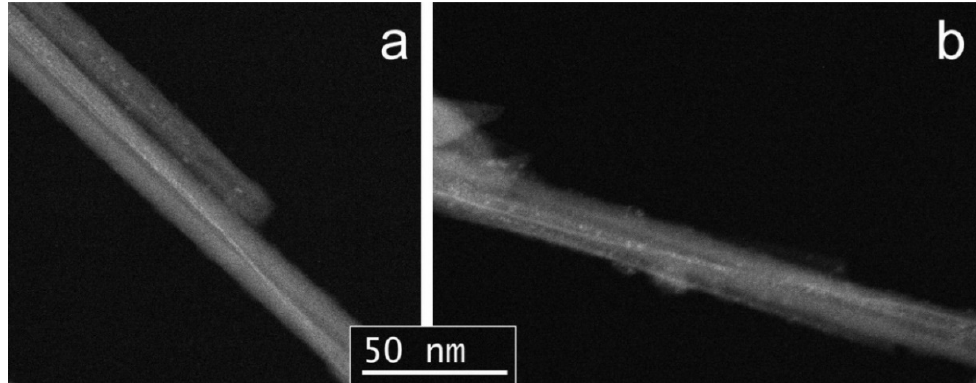
Figure 4. ( a , b ) HAADF images of arc-prepared MWCNTs treated with iodine showing examples of iodine lines probably following a helical path with respect to the MWCNT longitudinal axis.